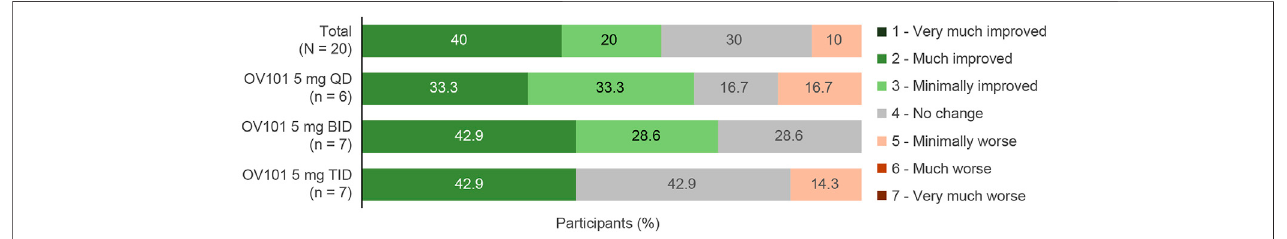
FIGURE 3 | CGI-I score at week 12. Among the 3 dosing regimens, the percentage of CGI-I responders was greatest with OV101 5 mg BID. CGI-I, Clinical Global Impressions – Improvement; OV101, gaboxadol; QD, once daily; BID, twice daily; TID, 3-times daily.